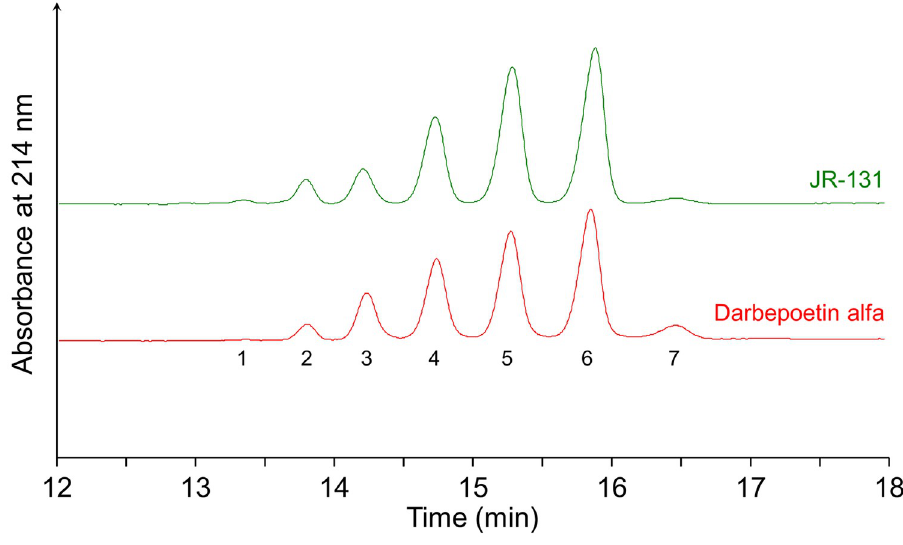
Fig 6. Capillary zone electropherograms of JR-131 and darbepoetin alfa. Charged isomers were labeled with peak numbers 1 to 7 in the direction from basic to acidic